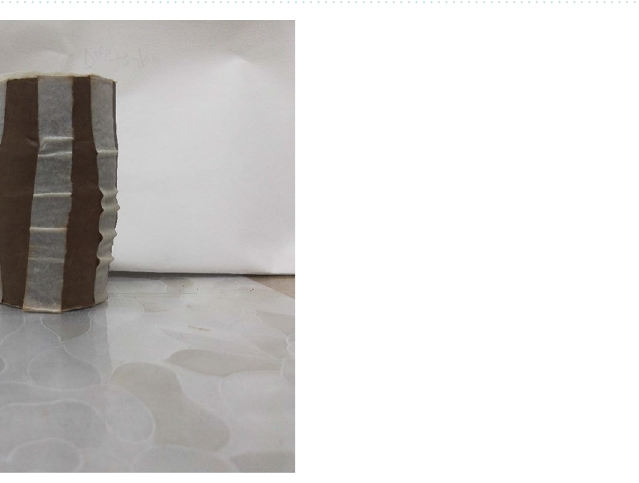
Figure 3. Bulging failure diagram of consolidated drainage